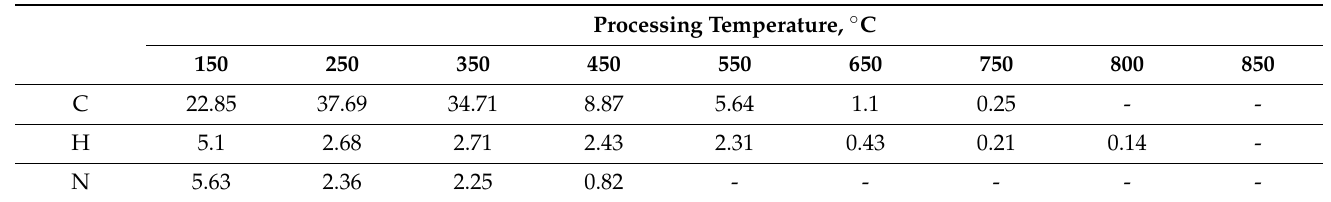
concentrated water–carbohydrate solution of Zn(NO 3 ) 3 .